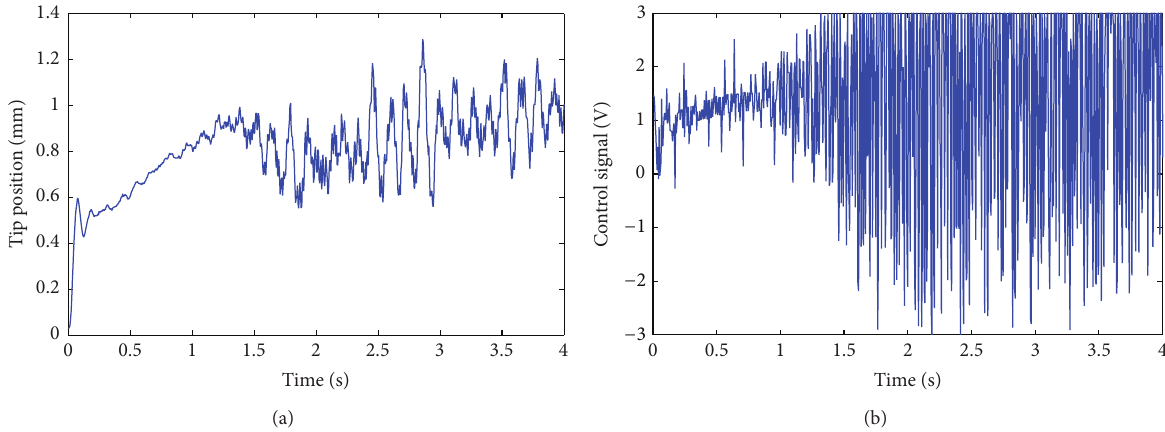
Figure 10: Step response of the closed-loop experimental system with the added mass using the integer-order controller: (a) tip position, (b) control signal.